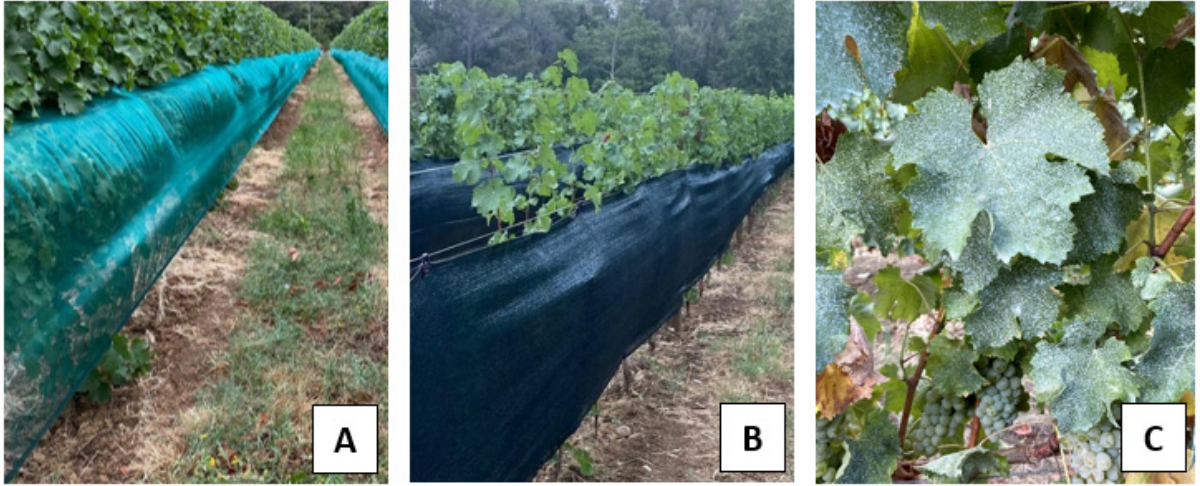
Figure 1. Different canopy management of Vitis vinifera cv. Sauvignon Blanc: SD-30% (green artifi- cial shading net at 30%; ( A )), SD-70% (green artificial shading net at 70%; ( B )), and K (kaolin; ( C